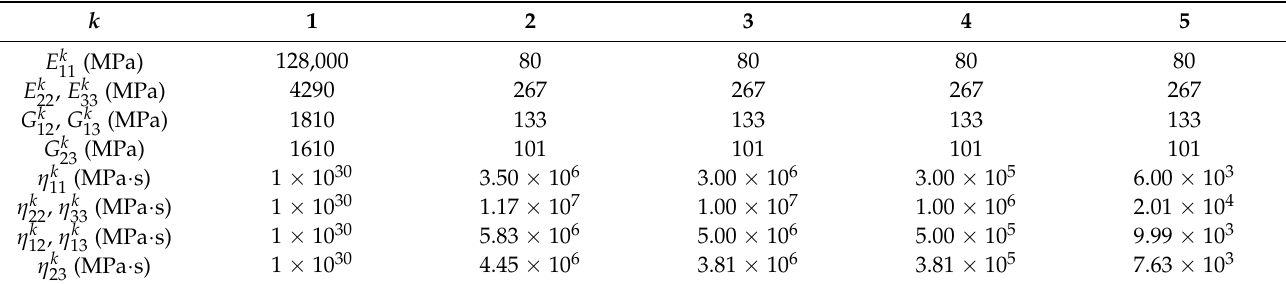
Table 2. Strength and degradation properties of CFRP laminate [41].